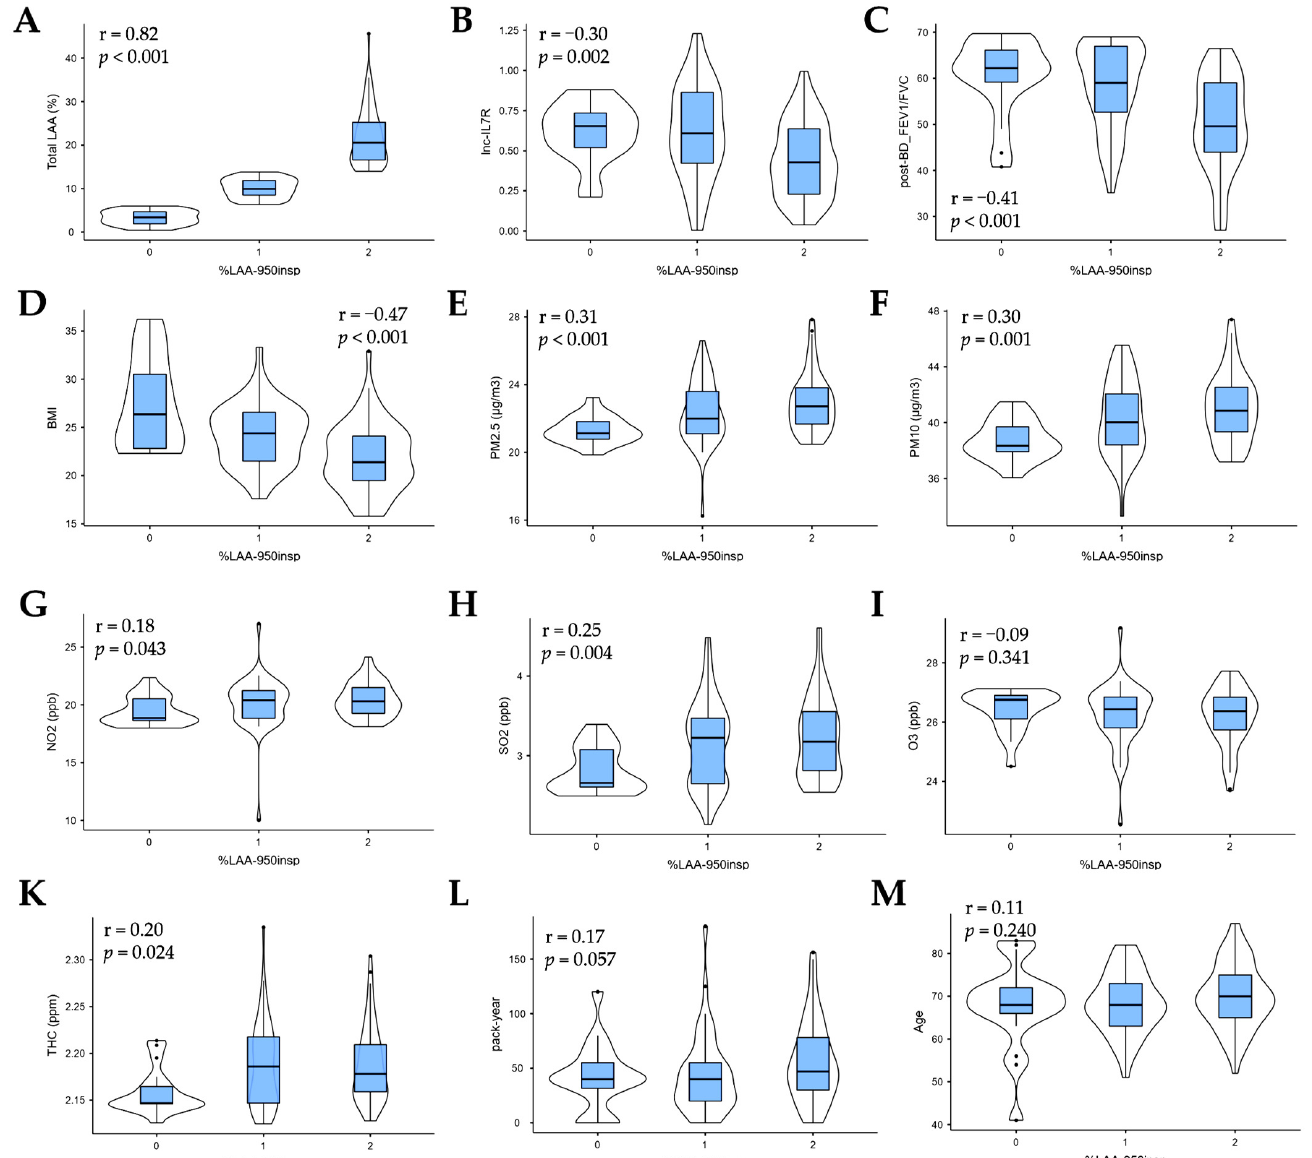
Figure 1. Disease risk modulators in Taiwanese patients with COPD-E. Violin plots with included box plots showing the correlation between ( A ) Total LAA, ( B ) lnc-IL7R , ( C ) post-bronchodilator FEV1/FVC ratio, ( D ) BMI, ( E ) PM 2.5 , ( F ) PM 10 , ( G ) NO 2 , ( H ) SO 2 , ( I ) O 3 , ( K ) THC, ( L ) pack-year, or ( M ) age, with %LAA -950insp -based COPD-E severity. COPD-E, emphysema in patients with COPD; r, Pearson correlation coefficient; %LAA -950insp , percentage of lung attenuation area with values less than − 950 Houns fi eld units on inspiratory CT scan. For %LAA -950insp : 1, no or mild emphysema (%LAA -950insp < 6); 2, moderate emphysema (6 ≤ %LAA -950insp < 14); and 3, severe emphysema (%LAA -950insp ≥ 14).